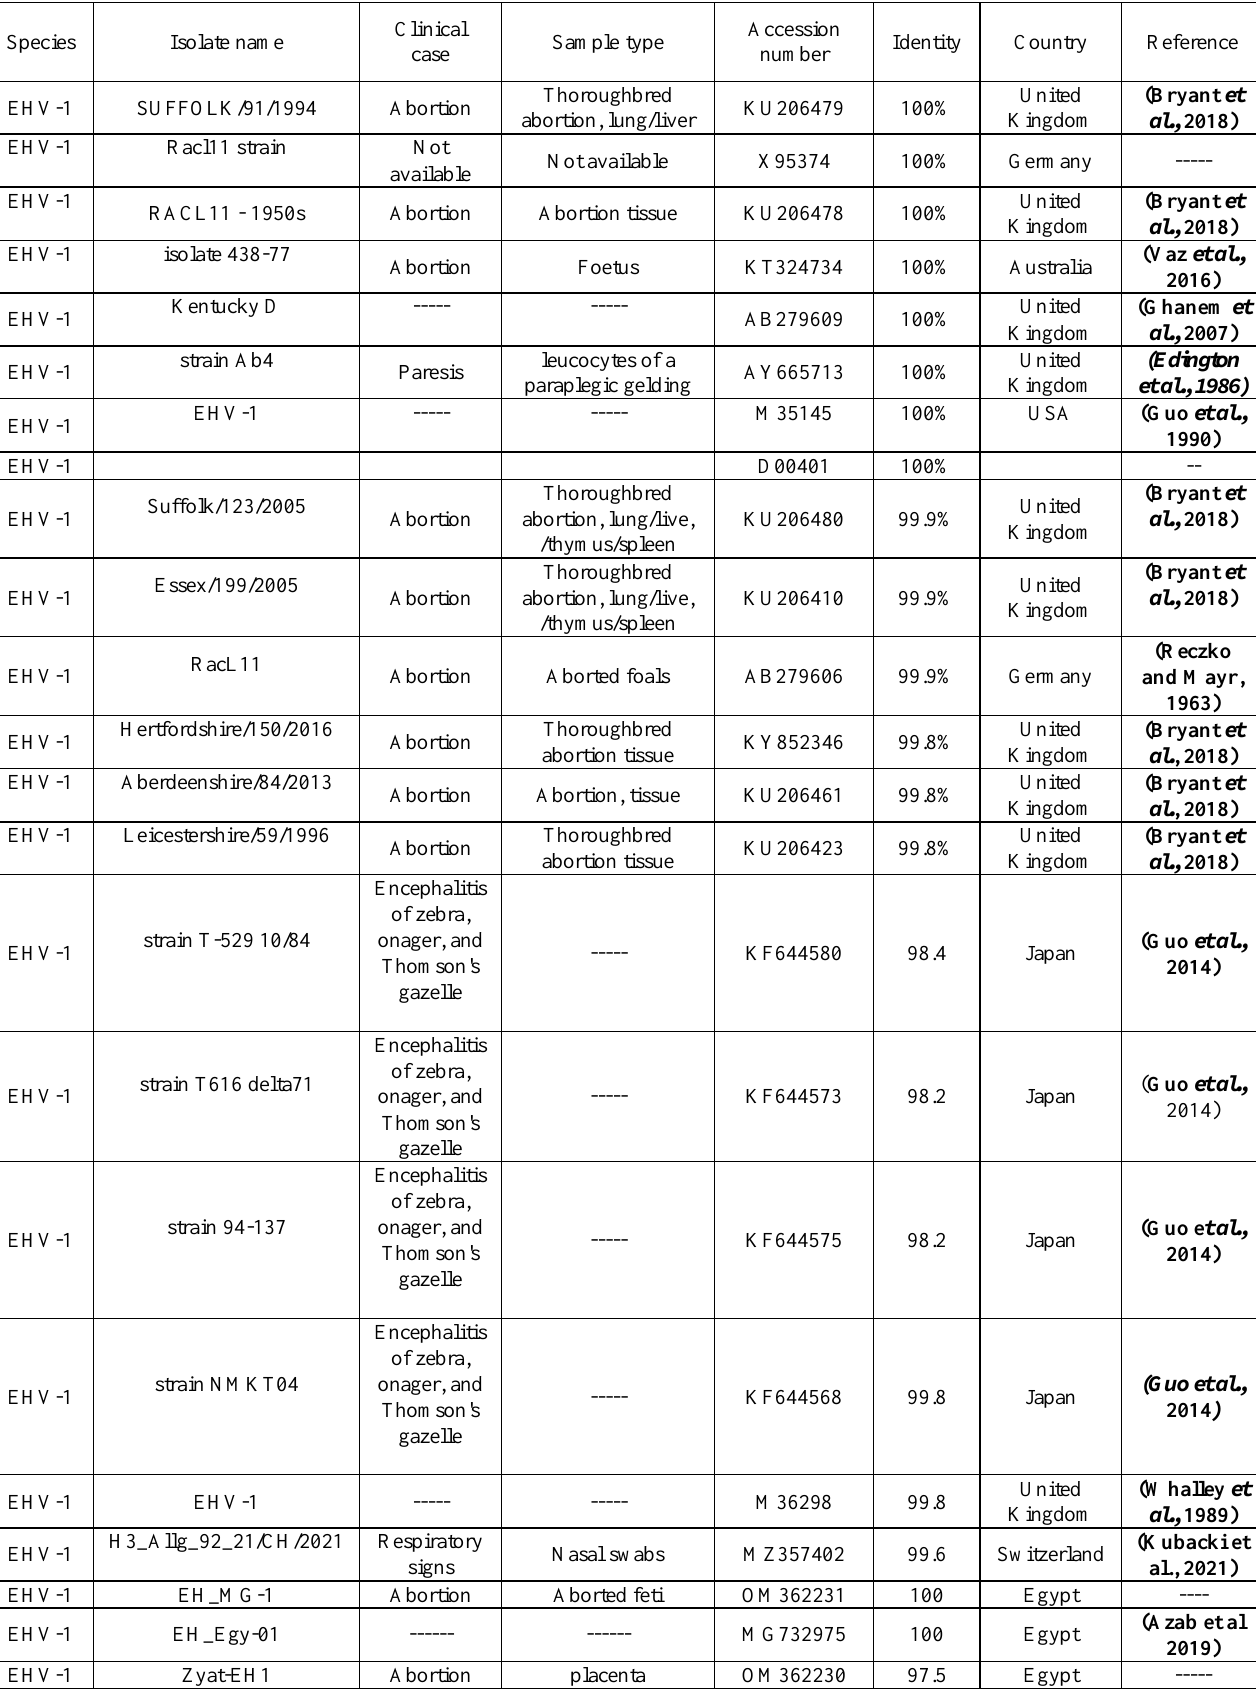
Table 3: Declares the data of the different isolates used for the